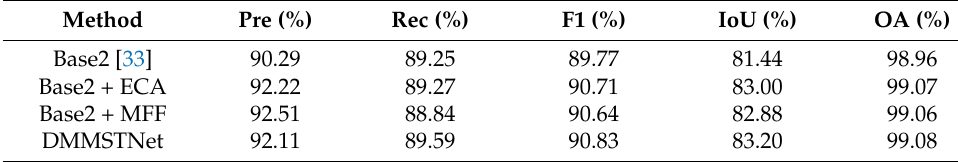
Figure 10. Ablation Base1 experimental results on the LEVIR-CD dataset. ( a ) The images at time1. ( b ) The images at time2. ( c ) The ground truth. ( d ) The results of Base1. ( e ) The results of “Base1 + CoT”. ( f ) The results of “Base1 + Transformer”. Table 3. Numerical Ablation Base1 Results on LEVIR-CD Dataset. Table 5. Numerical Ablation Base2 Results on LEVIR-CD Dataset.